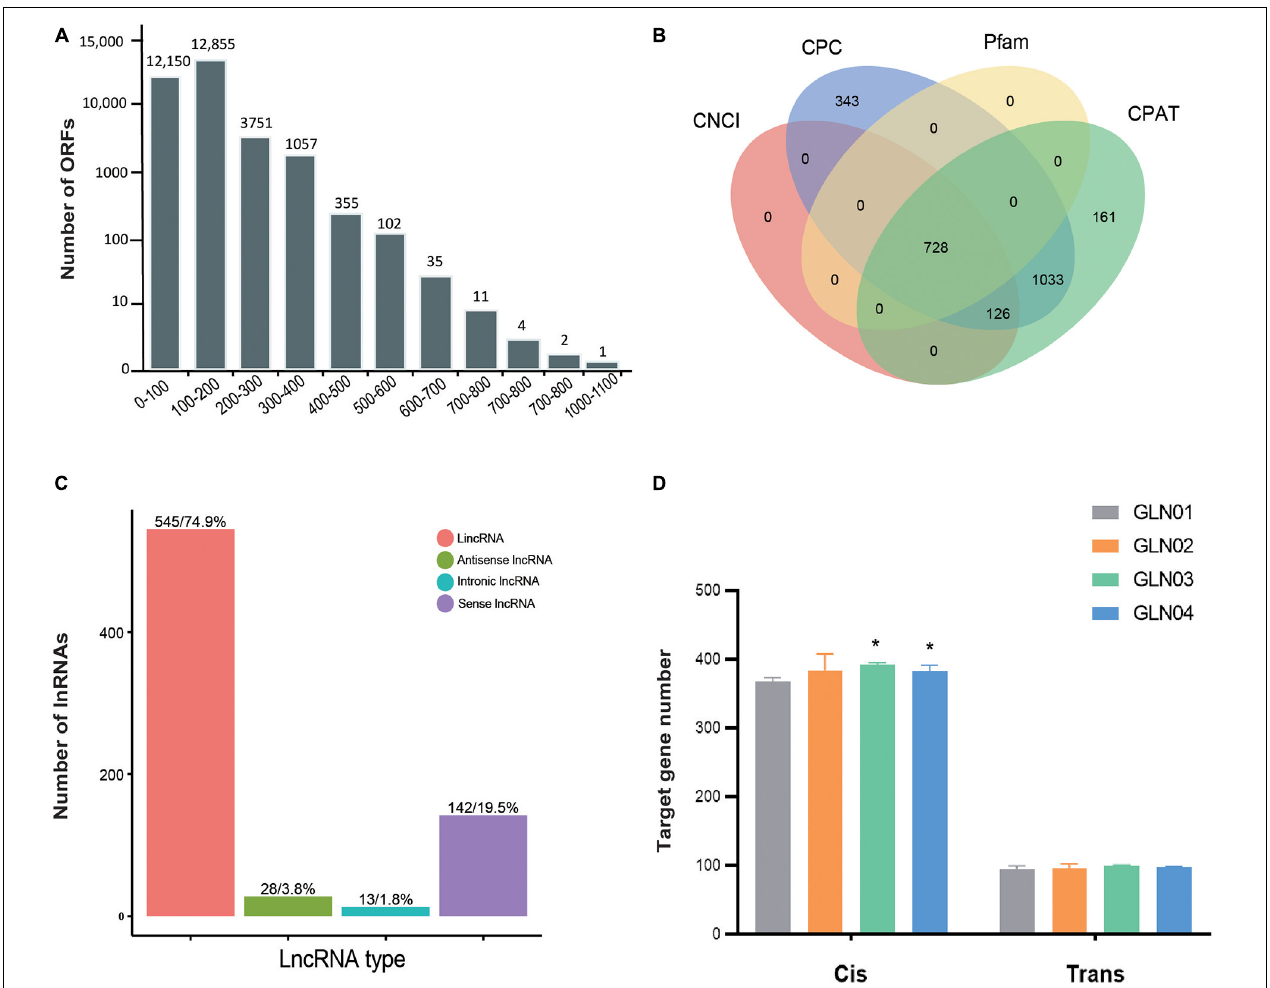
FIGURE 3 | Identification of ORFs and lncRNAs based on 12 full-length transcriptome. (A) Length distribution of ORFs detected in all full-length transcripts. (B) Venn diagram showing the number of lncRNAs identified using four different approaches: CPC, CNCI, CPAT, and Pfam. (C) Functional classification and numbers of four lncRNA types. (D) Target genes regulated by lncRNAs in cis and in trans across four developmental stages. Symbol * indicates the p values < 0.05 using Student’s t-test